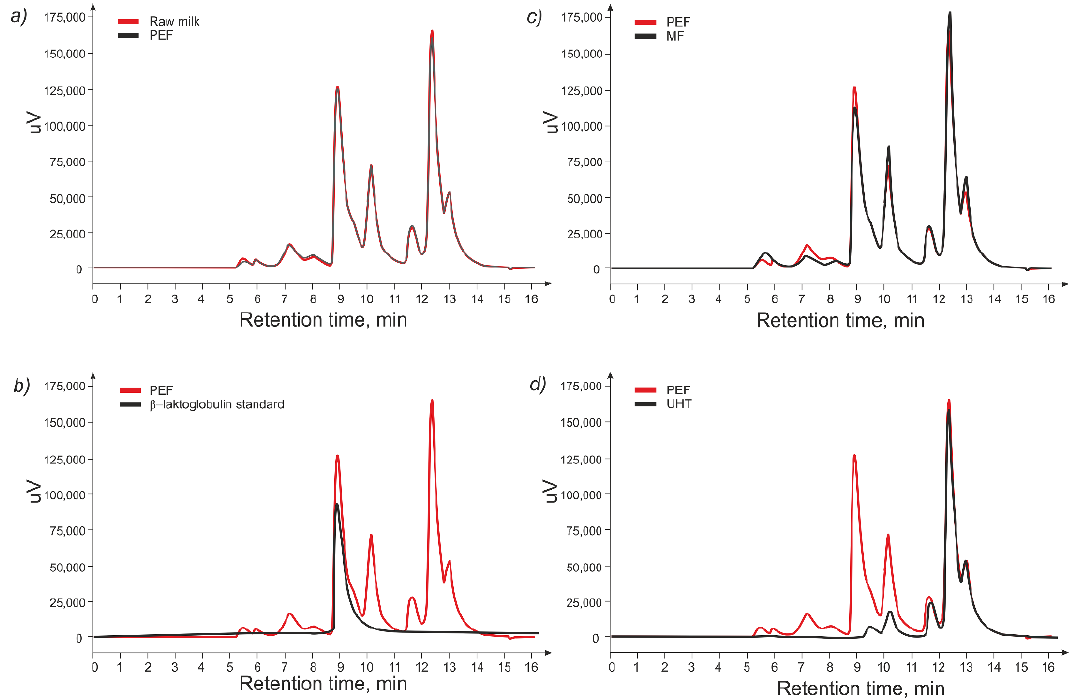
Figure 6. HPLC results on β -lactoglobulin content in raw milk samples and those treated with PEF, ( a ); HPLC results on β -lactoglobulin content in PEF-treated samples and β -lactoglobulin standard, ( b ); HPLC results on β -lactoglobulin content in milk samples treated with MF and PEF, ( c ); HPLC results on β -lactoglobulin content in milk samples treated with UHT and PEF, ( d ).